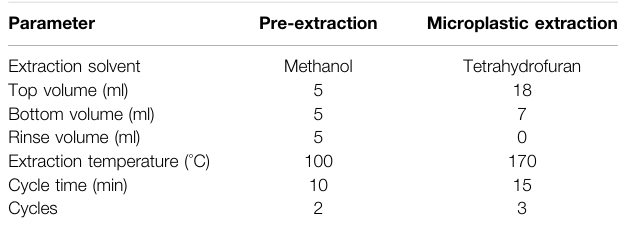
TABLE 2 | Indicator compounds and selected indicator ions in the pyr-GC-MS analysis (m/z, mass/charge; t R , retention time).